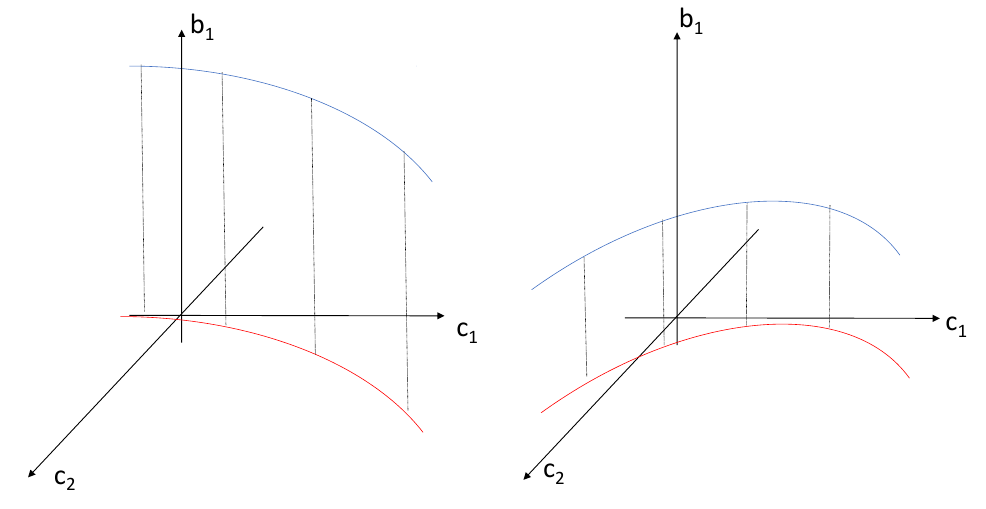
Figure 2 . A depiction of the process of primary decomposition and then elimination as applied to the variety pictured in (cid:12)gure 1. The red lines are the (cid:12)nal loci obtained in complex structure moduli